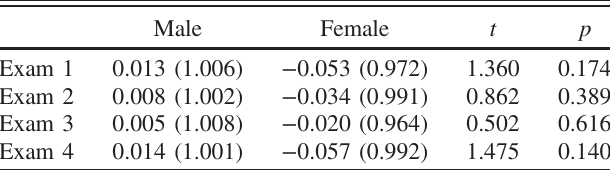
TABLE IV. Average exam z scores (and standard deviation) for calculus-based E&M, as well as the t test and significance between these distributions.